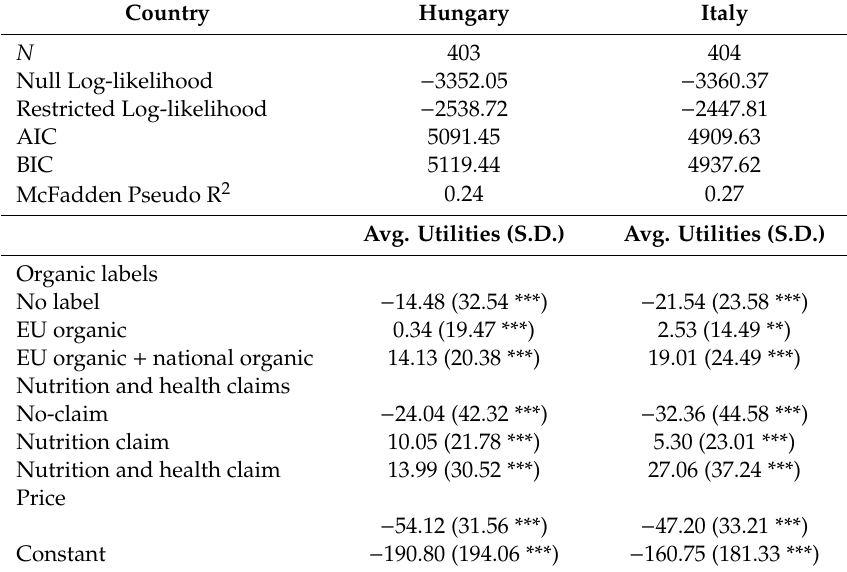
Table 4. Empirical results from random parameter logit models of the cross-country DCE data. Country